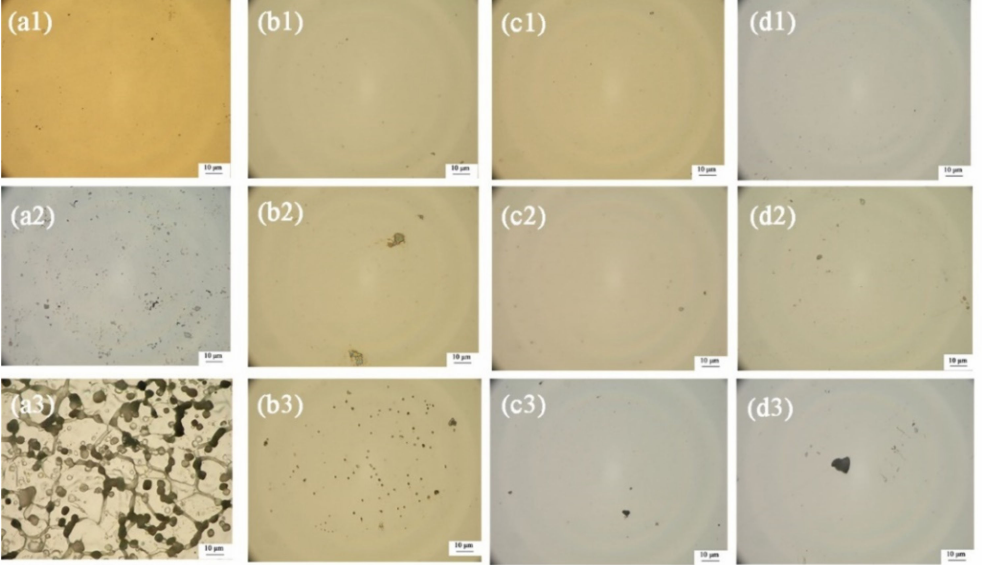
Figure 7. Surface morphology of SS316L and TiMoN coatings before and after high-potential polariza- tion ( a1 – d1 ) pre-polarization, ( a2 – d2 ) 1.0 V SCE , ( a3 – d3 ) 1.2V SCE ; ( a1 – a3 ) SS316L, ( b1 – b3 ) TiMoN-2A,